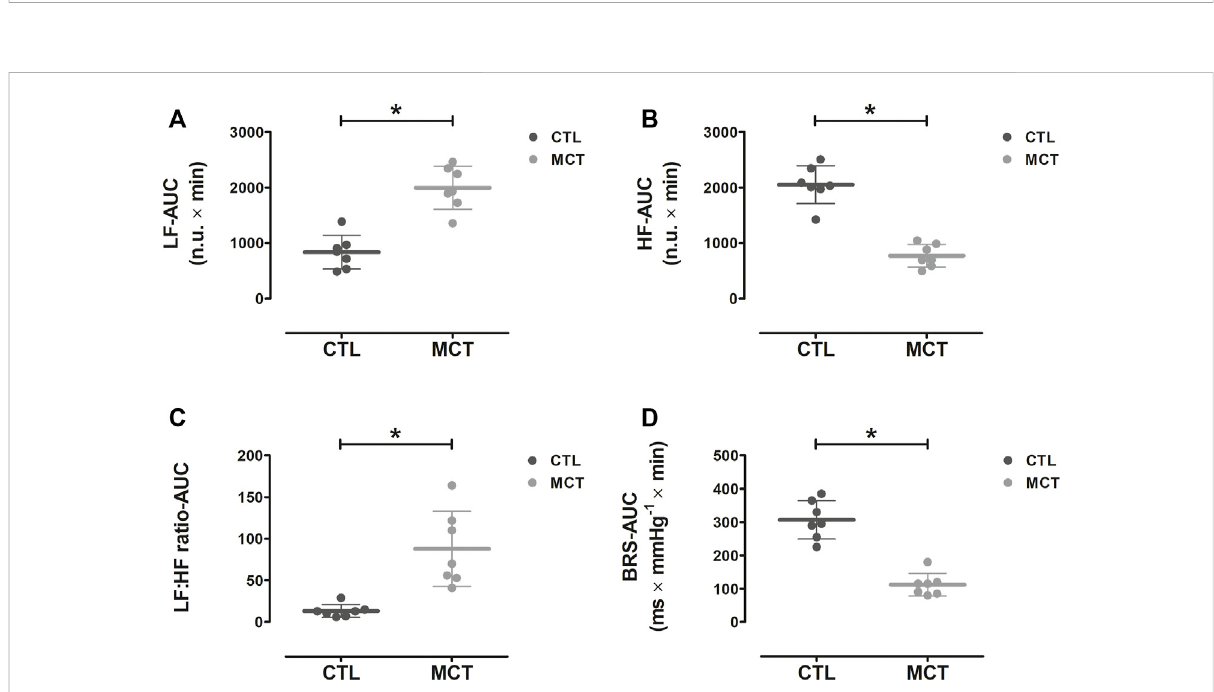
FIGURE 5 Mean ± SD AUCs for LF (A) , HF (B) , InLF:HF ratio (C) , and BRS (D) during the fi rst 40 min after the experimental trials. AUC, area under the curve; MCT, mixed circuit training; CTL, non-exercise control session; LF, low-frequency component; HF, high-frequency component; InLF:HF ratio, logarithmically transformed sympathovagal balance; BRS, barore fl ex sensitivity. *, Signi fi cant difference between CTL vs. MCT ( p <